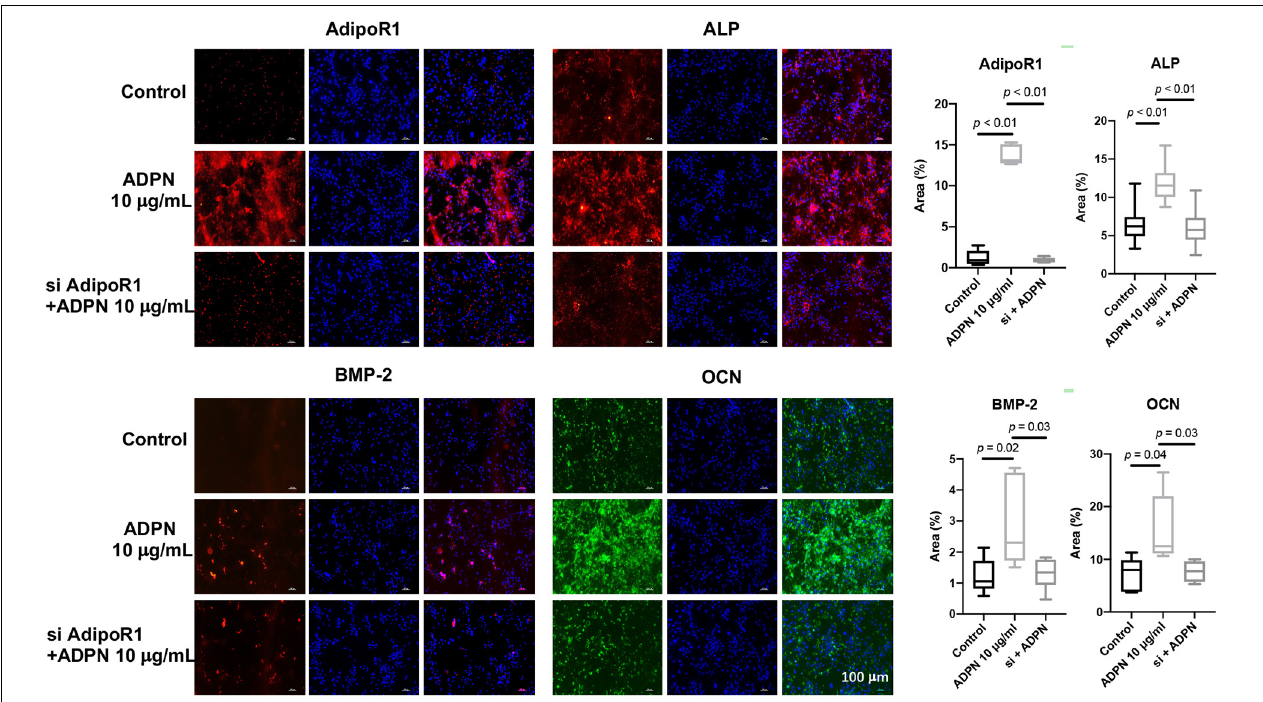
FIGURE 7 | The immunofluorescent staining of ALP, OCN, BMP-2, and AdipoR1 on BMSCs with ADPN 10 µ g/ml and AdipoR1 siRNA + ADPN 10 µ g/ml, and the corresponding quantification, scale bar = 100 µ m.